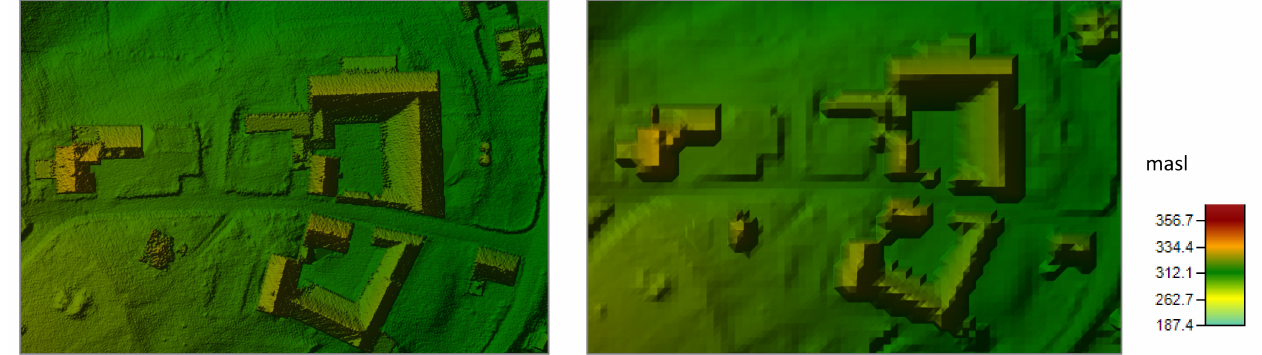
Figure 7. Buildings in the modeling domain using different DEM resolution: on the left: 0.25 m resolution, on the right: 2 m resolution.